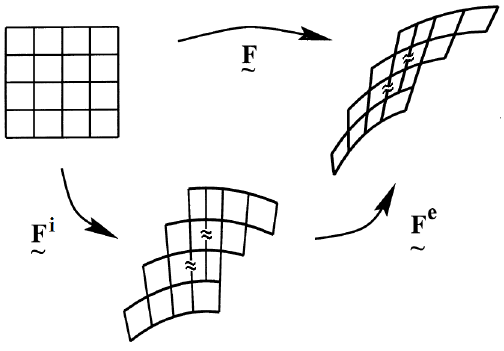
Figure 1. Decomposition of the deformation